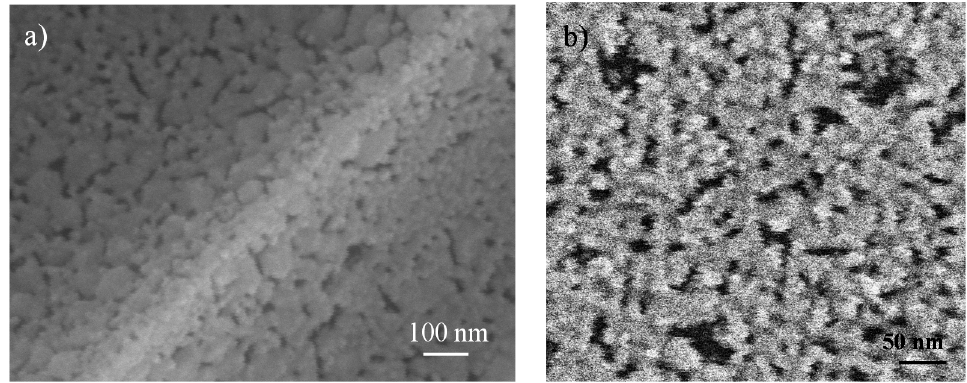
Figure 2. FE-SEM micrographs for L i4 Ti 5 O 12 thin-film heat-treated at 700 °C, 15 min ( a ) cross-section and ( b ) surface.